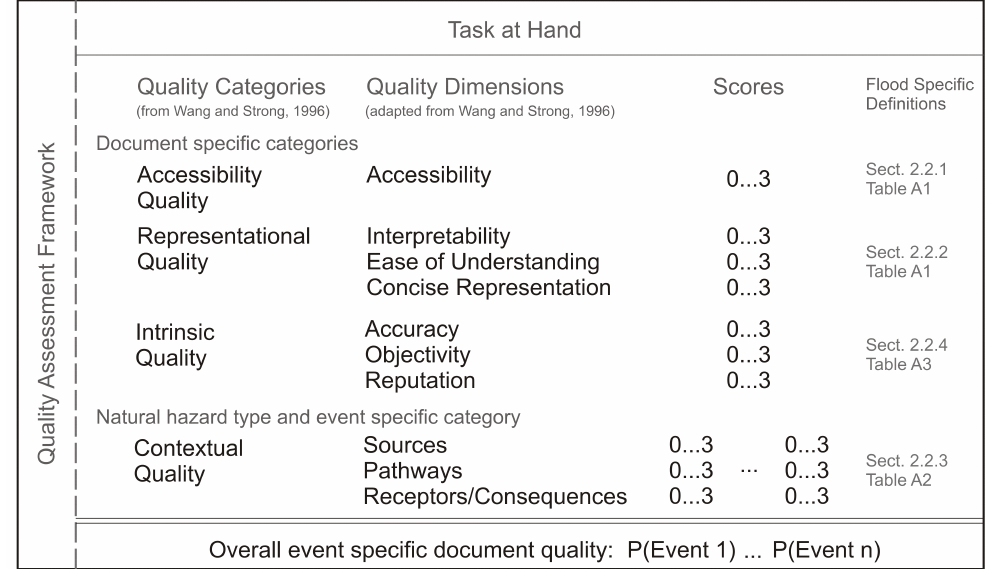
Fig. 1. Overview of the quality assessment framework.